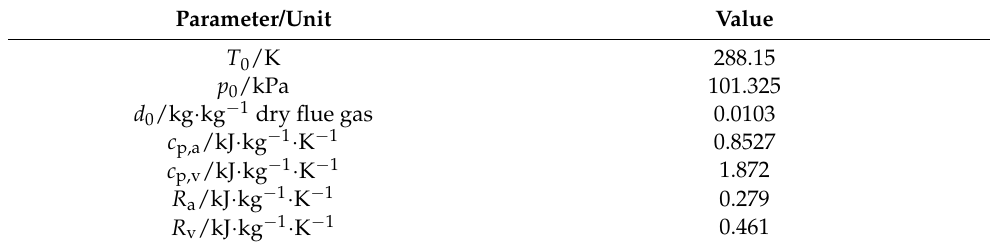
Table 1. The parameters of environment and wet flue